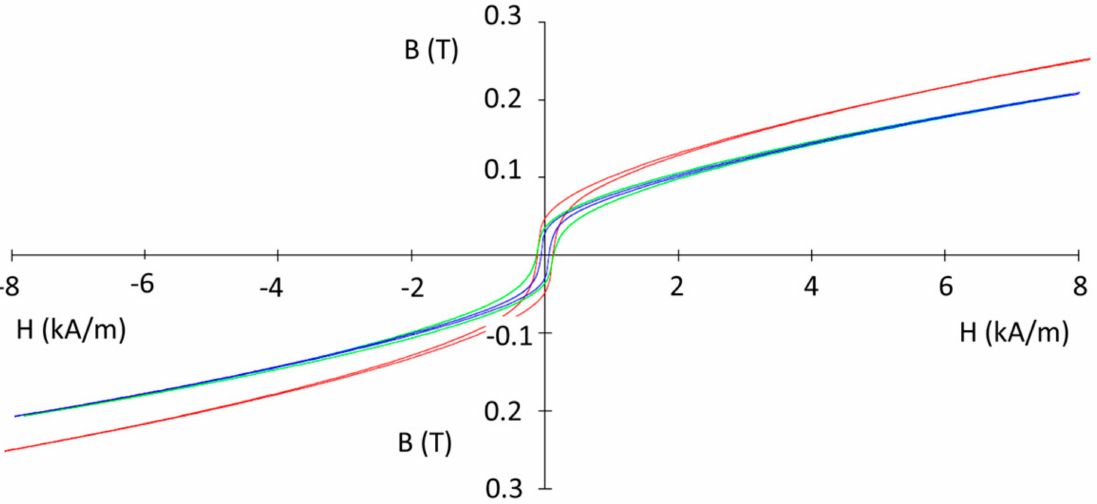
Figure 12. The B–H hysteresis curves in DC of the (Ni 3 Fe, supermalloy)/Mn 0.5 Zn 0.5 Fe 2 O 4 composite compacts with 1 and 2 wt. % of MnZn ferrite, SPS-ed at temperature of 500 ◦ C, 0 min holding time.